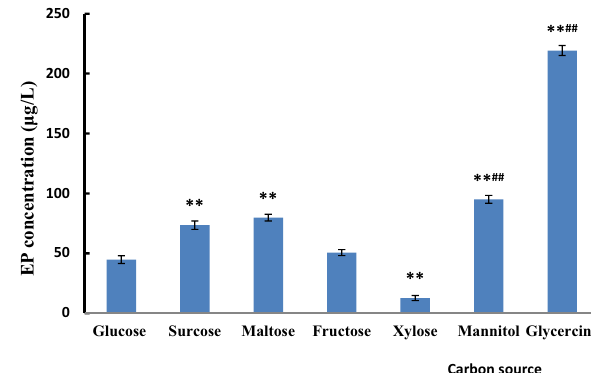
Figure 1. Effect of carbon sources on the EP concentration. ** p ≤ 0.01, compared with the glucose using carbon sources; ## p ≤ 0.01, compared with the maltose, sucrose, and fructose using as carbon sources, respectively. The other components of THE medium were the same, and the culture was carried in a rotary shaker at 25 °C and 120 rpm for 48